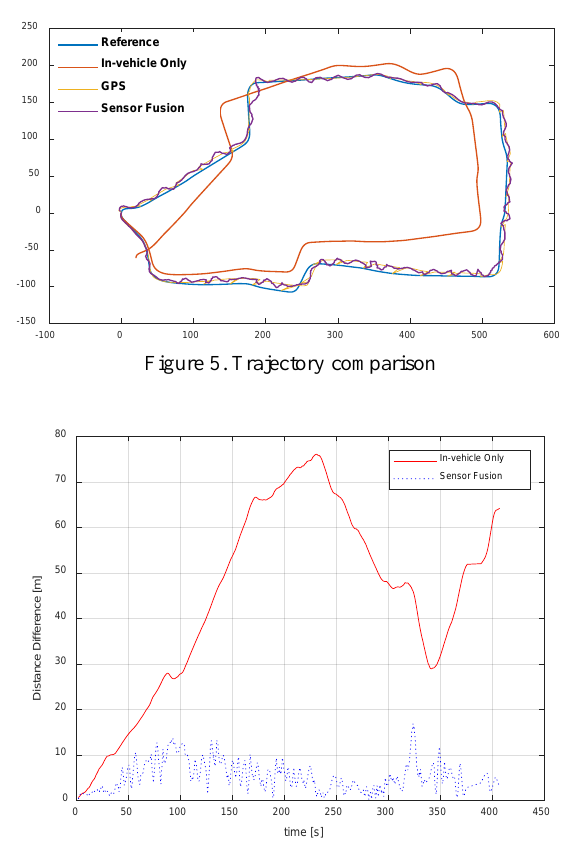
Figure 6. Comparison of position difference